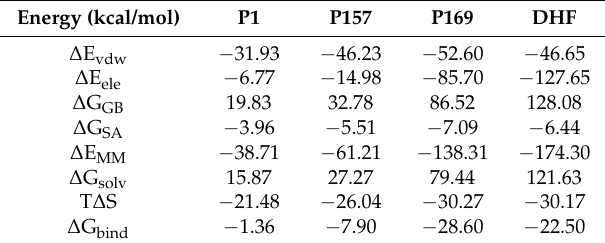
The average binding free energy ( ∆ G bind ) and the energy components for each mtbDHFR-NADPH-ligand complex from Molecular Mechanics/Generalized Born Surface Area (MM/GBSA) calculations. Energy (kcal/mol) P1 P157 P169 DHF ∆ E vdw